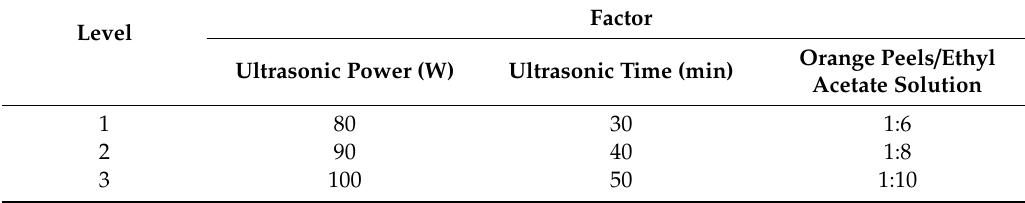
Table 1. Orthogonal test level of ultrasound-assisted extraction of orange-peel oil